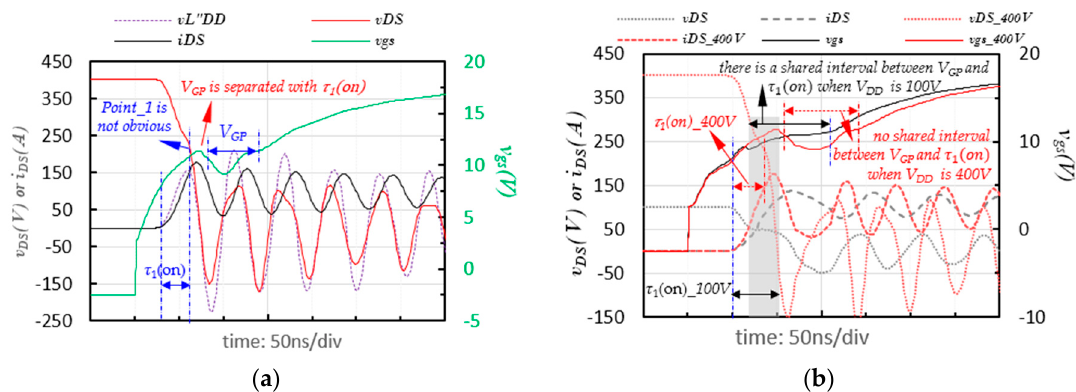
Figure 16. The simulation results about the influence of the increased V DD on characteristics of drain-source voltage plateau: ( a ) voltage waveforms under condition of 400 V / 100 A, ( b ) comparison between V DD of 400 V (in red color) and 100 V (in black color).